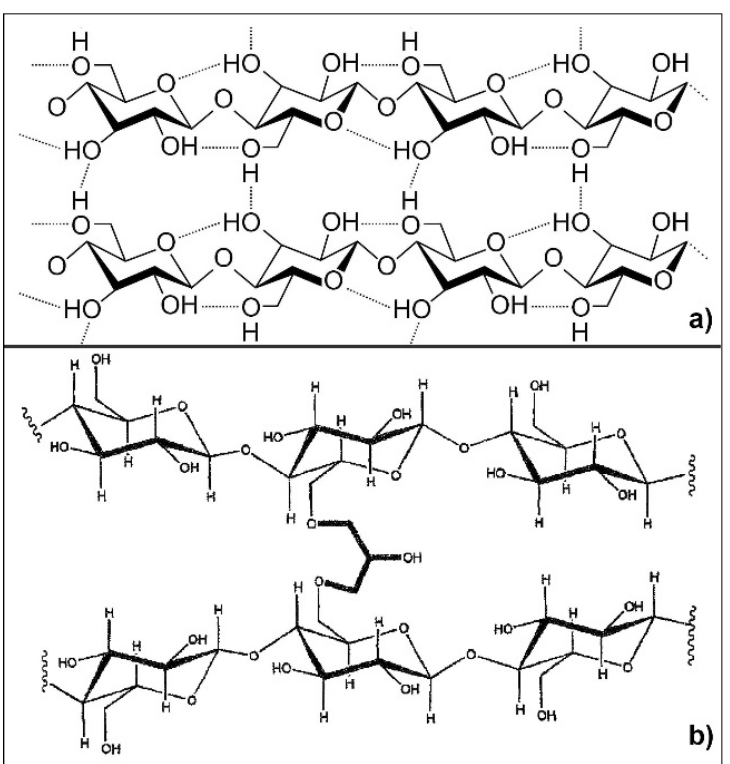
Figure 2. ( a ) Scheme of cellulose physical crosslink (intra- and inter-molecular hydrogen bonds); and ( b ) scheme of cellulose chemical crosslink (ether